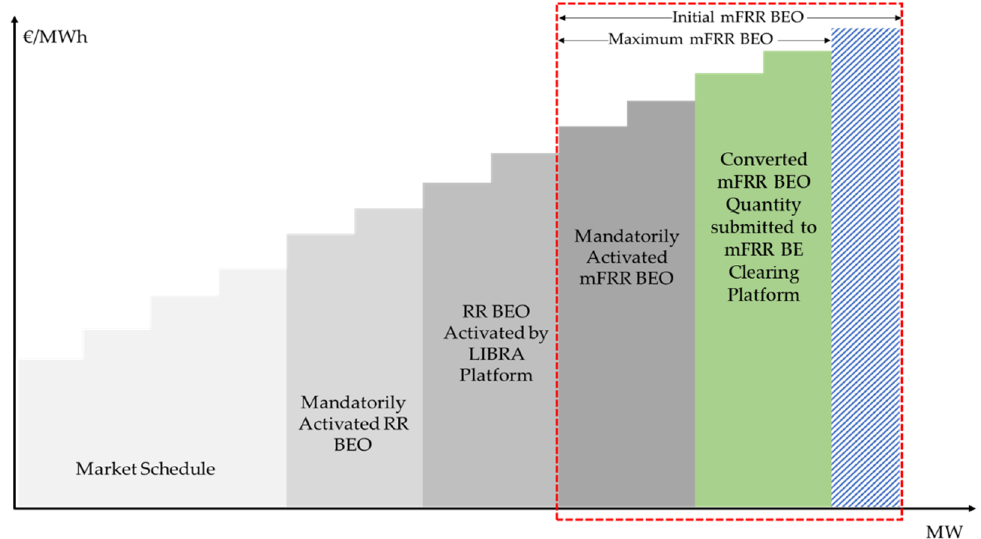
Figure 4. Conversion of an upward mFRR BEO before its insertion in the mFRR ΒΕ clearing model.